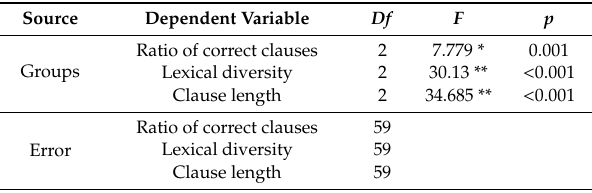
Table A3. Linguistic measures tests of between-subjects e ff ects.